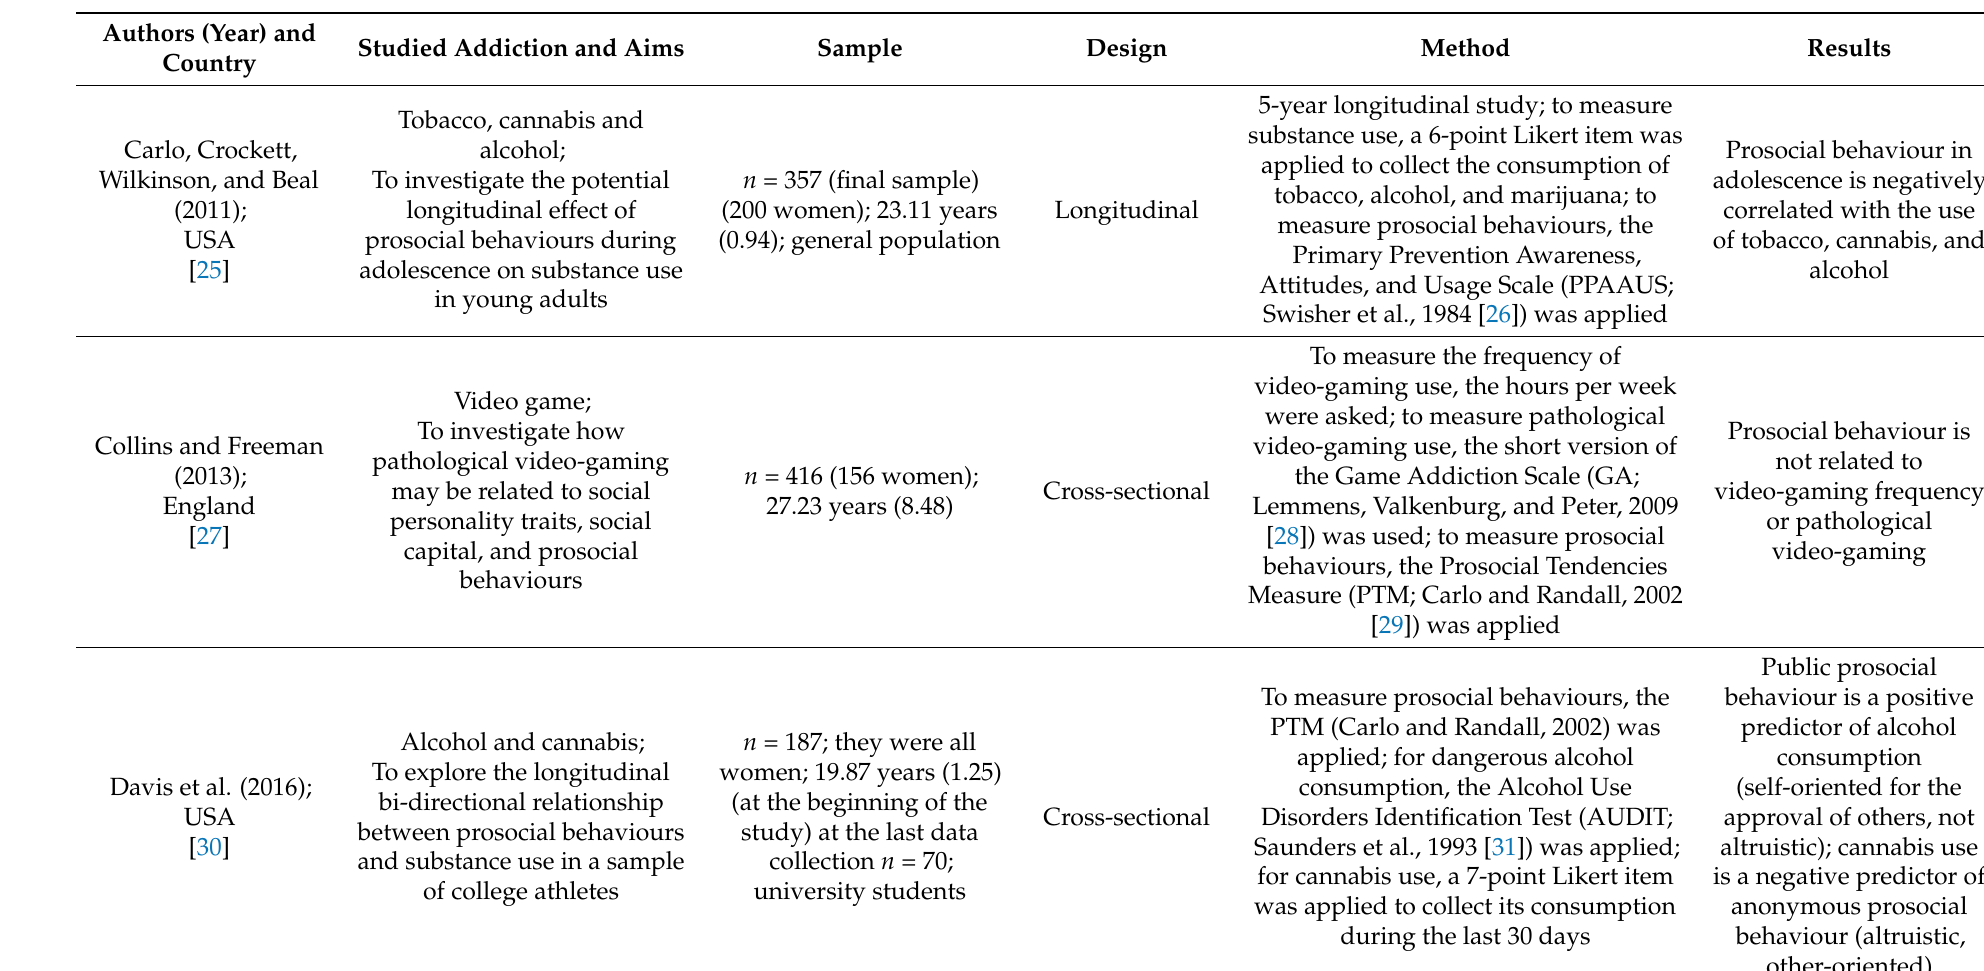
Table 1. Information of the articles selected for the